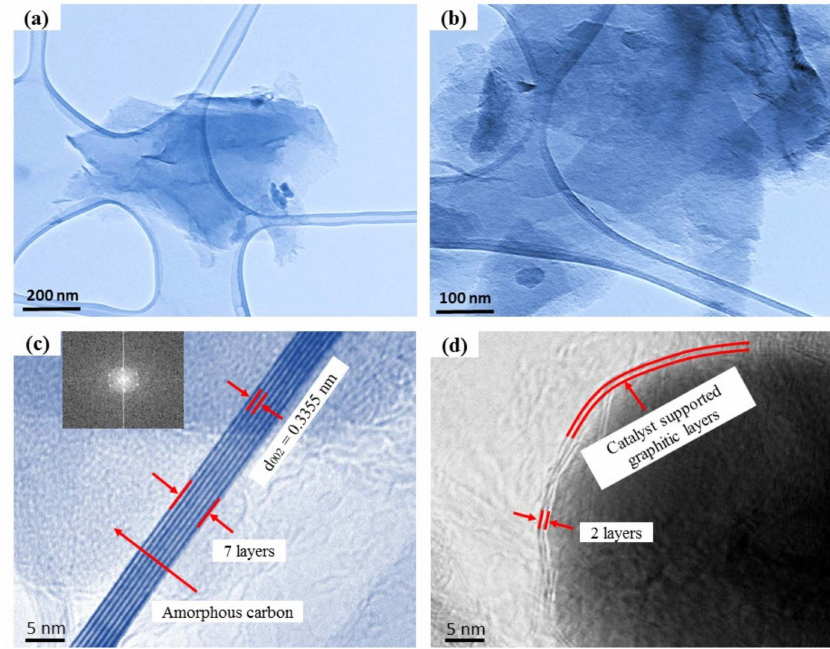
Figure 2. ( a , b ) Different magnifications of the TEM images of the S5% Fe-Ni sample; and ( c , d ) HRTEM images of the S5% Fe-Ni sample containing two to seven layers of graphene. The inset in ( c ) shows the FFT image of the corresponding